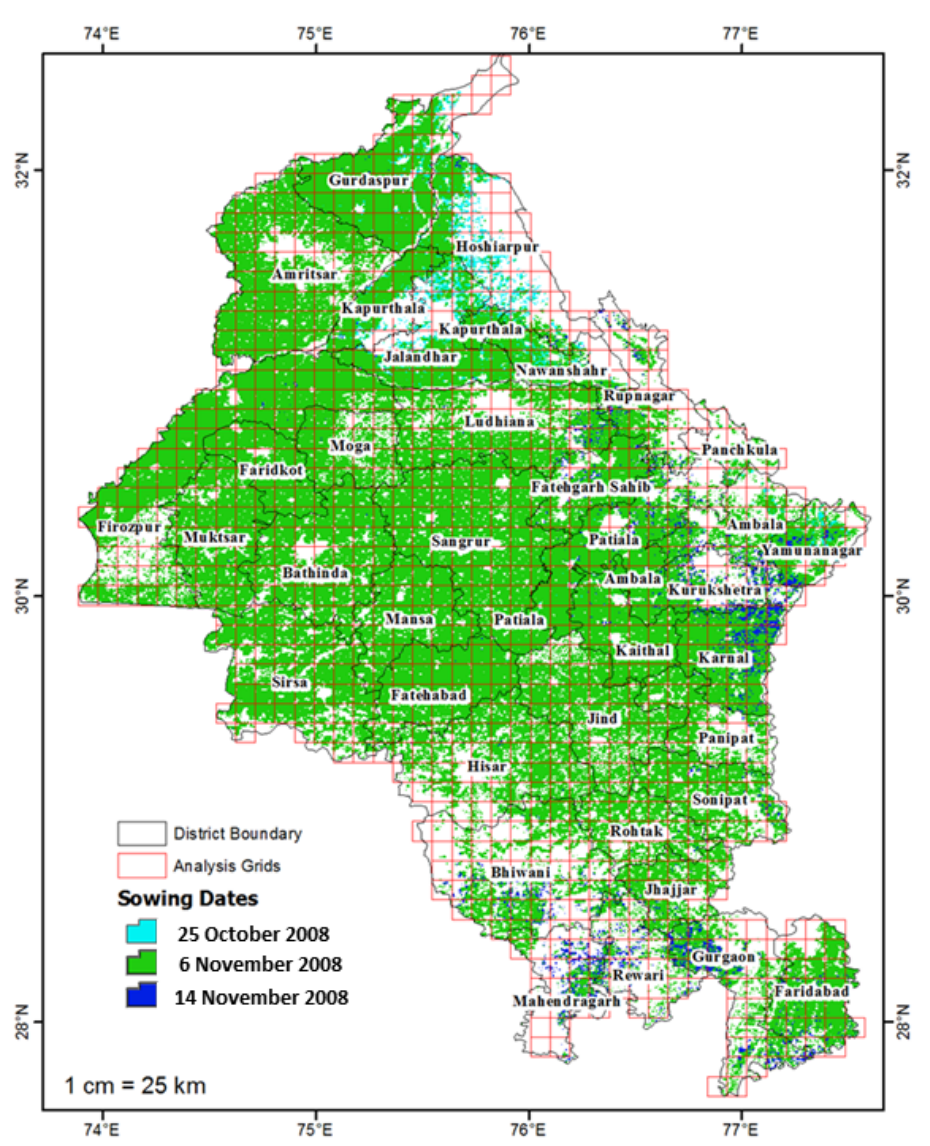
Figure 3. Areal extent map of wheat crop with sowing dates and analysis grids.